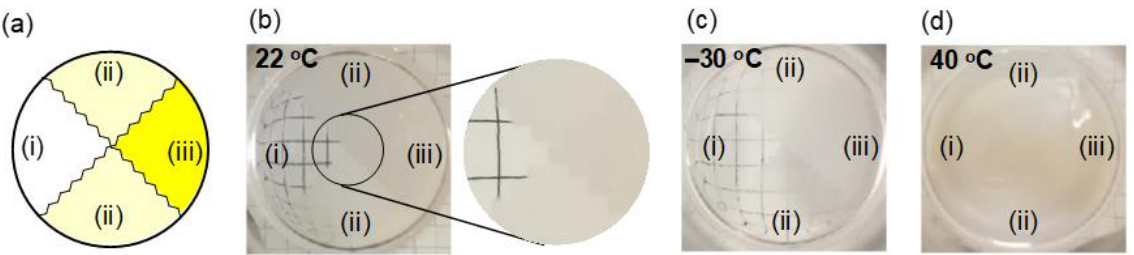
Figure 7. ( a ) Schematic illustration of photopatterning on a gel with different irradiation time ((i) 0 min, (ii) 5 min, and (iii) 10 min) and ( b – d ) photographs of the photopatterned P1b-gel at different temperatures: ( b ) at 22 °C with the enlarged view of the boundary area, ( c ) at −30 °C after maintaining for 0.5 h, and ( d ) at 40 °C after maintaining for 0.5 h.